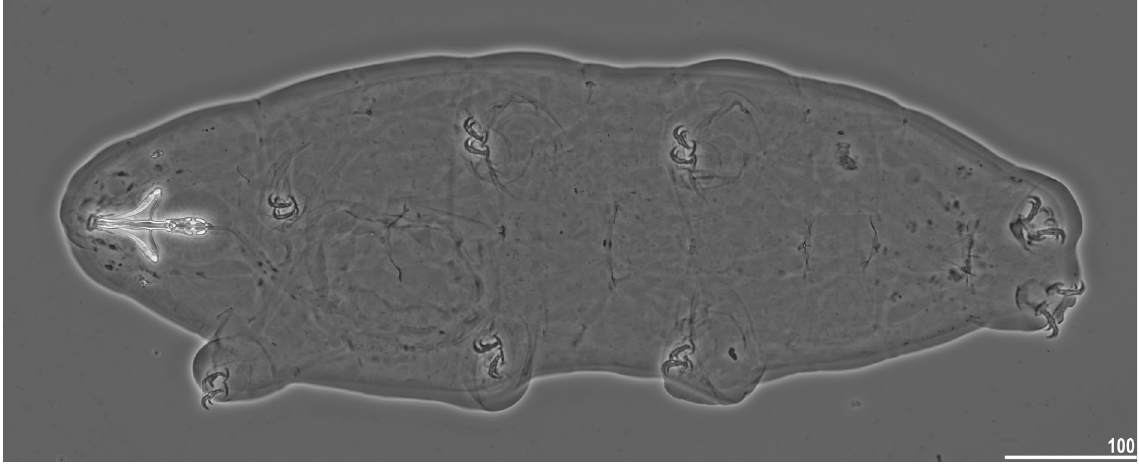
Fig. 10. Tenuibiotus zandrae sp. nov. Habitus. Dorso-ventral projection (holotype, IZiBB, slide GL.011.17, Hoyer’s medium, PCM). Scale bars in